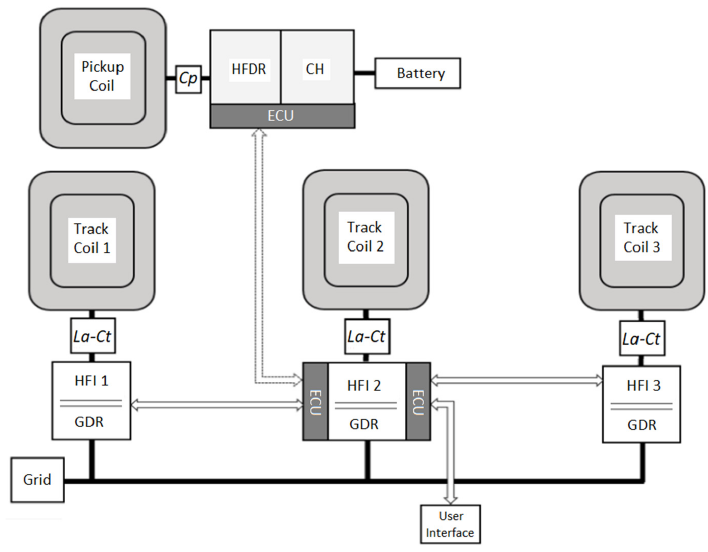
Figure 15. Layout of the WPT system.